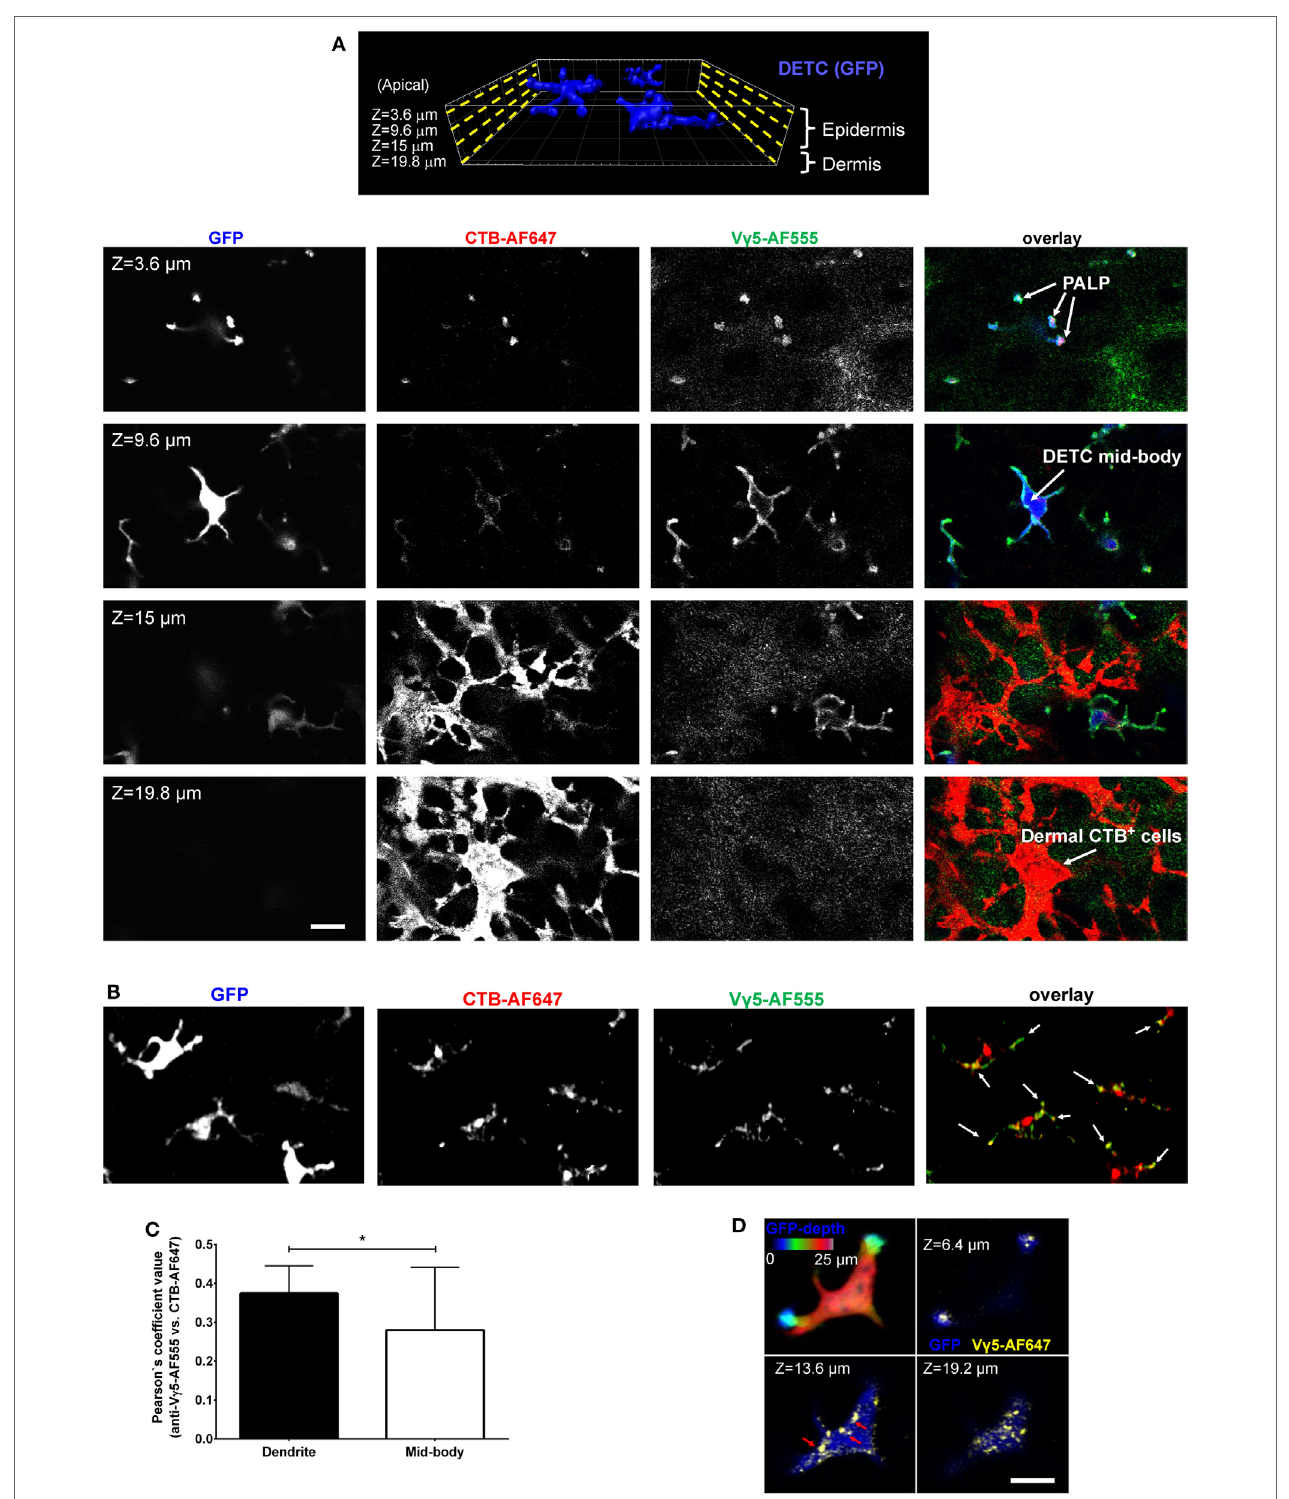
FigUre 1 | Intravital skin labeling by intradermal injection of fluorescent anti-V γ 5 antibody and CTB in IL2p8-GFP mouse ear. (a) One hour from the injection. Four representative confocal image z-planes from a 3-D z-stack at the indicated z-depth positions measured from the apical skin surface. (B) Six days after injection (different site). Maximum intensity projection of a confocal image z-stack. The white arrows point to the apical dendrite positions. (c) Quantification of V γ 5 and CTB signal co-localization after 6 days. (D) 3-D confocal sectioning to demonstrate the cytoplasmic localization of the granules 6 days after labeling. The color-coded depth projection shows the entire dendritic epidermal T cell (DETC) body. Scale bars = 10